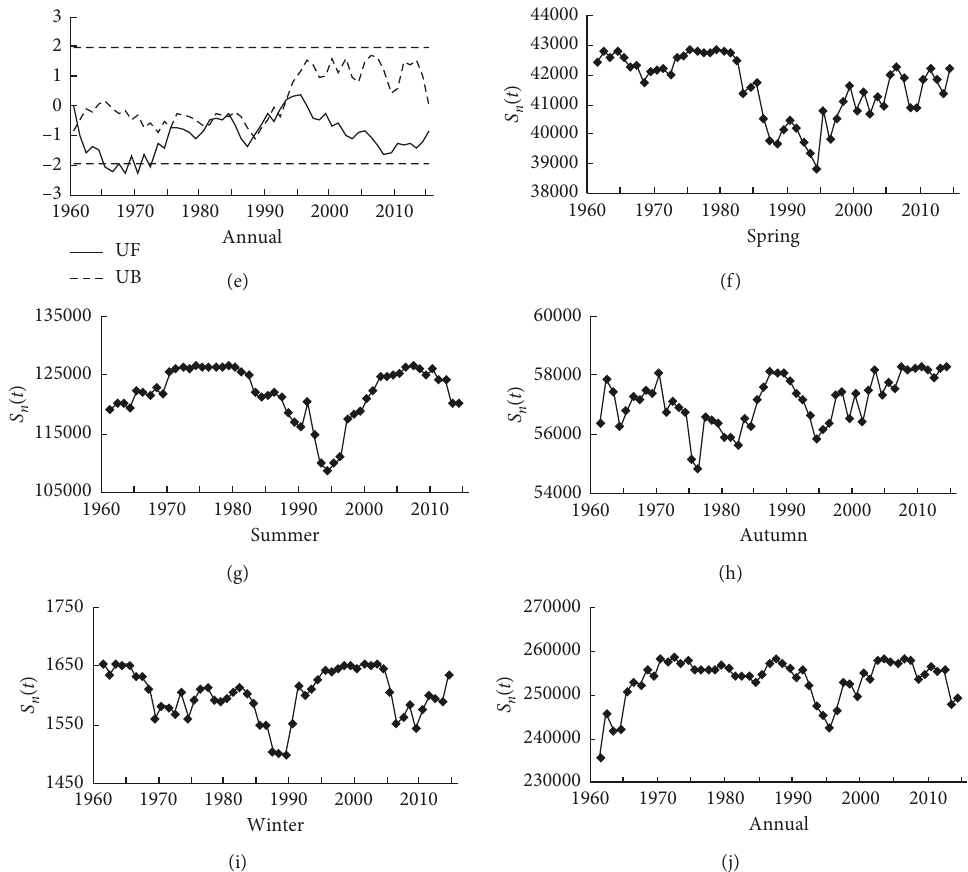
Figure 7: Change point diagnosed graphs by Mann–Kendall test of abrupt (a–e) and sequential cluster analysis (f–j) in the UMR. Horizontal dashed lines denote the confidence at level of